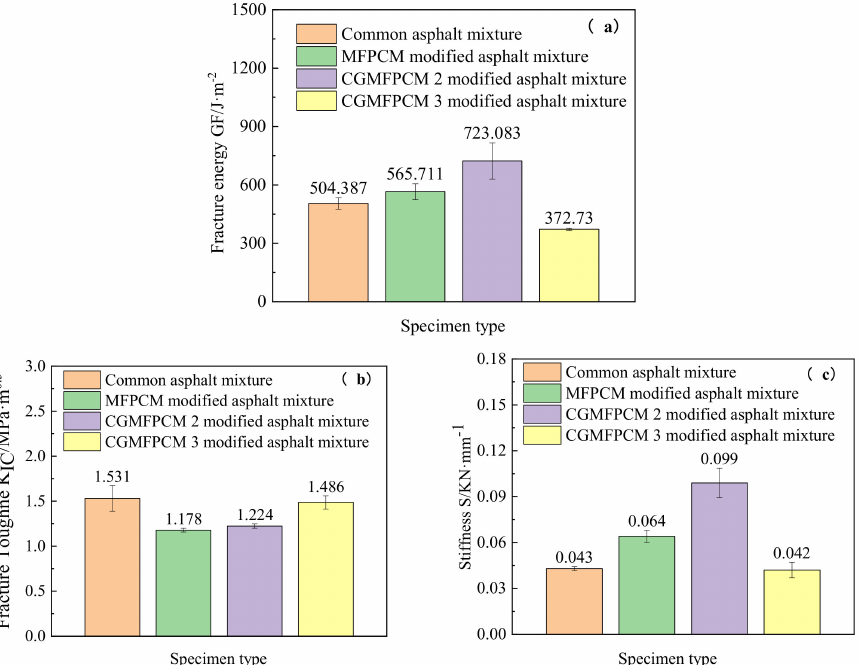
Figure 3. SCB test ( − 20 ◦ C) results for common and modified asphalt mixtures: ( a ) the fracture energy G f , ( b ) the fracture toughness K IC and ( c ) the stiffness